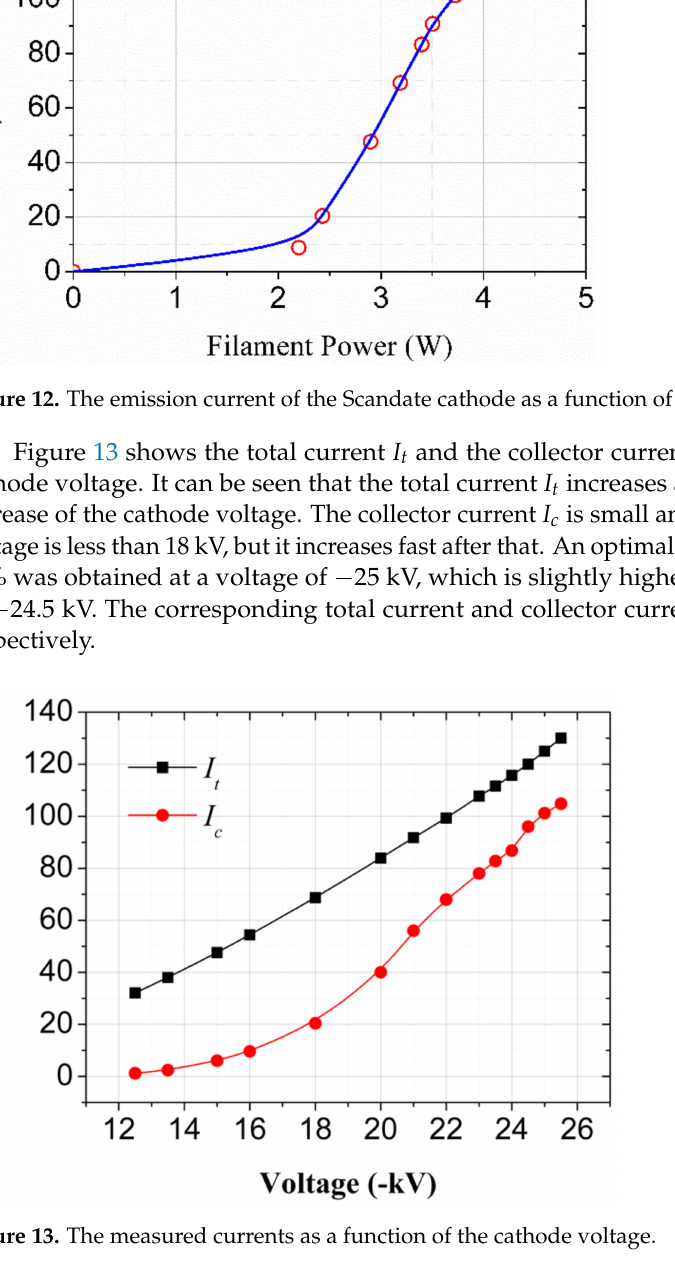
Figure 13. The measured currents as a function of the cathode